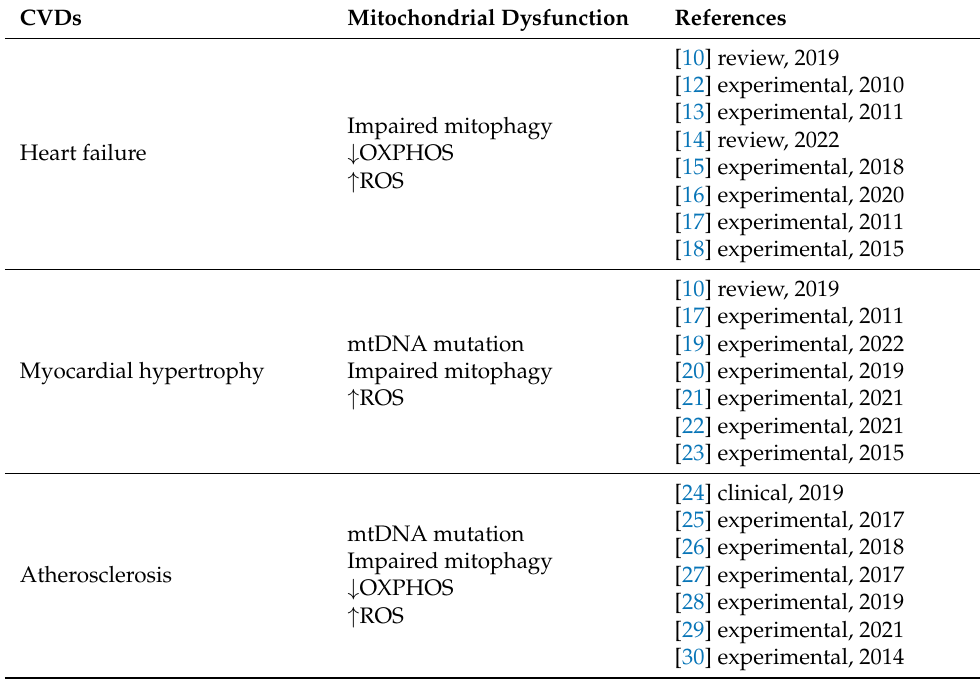
Table 1. CVDs and corresponding mitochondrial